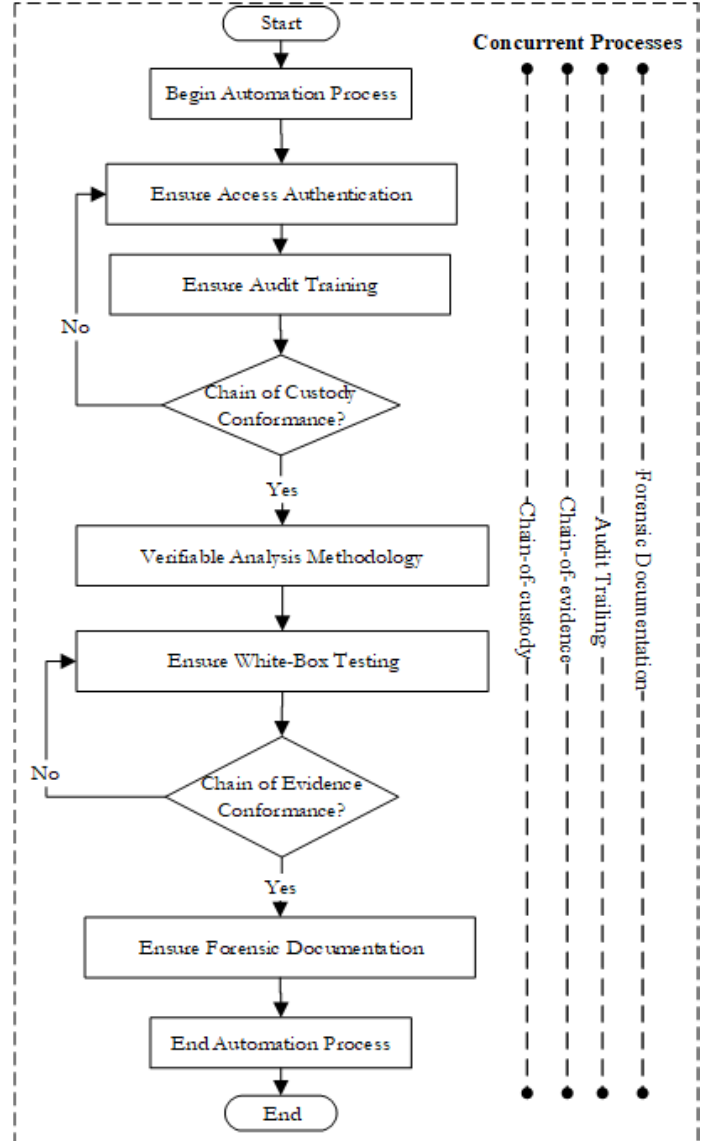
Figure 1. Push button forensics reliability assurance